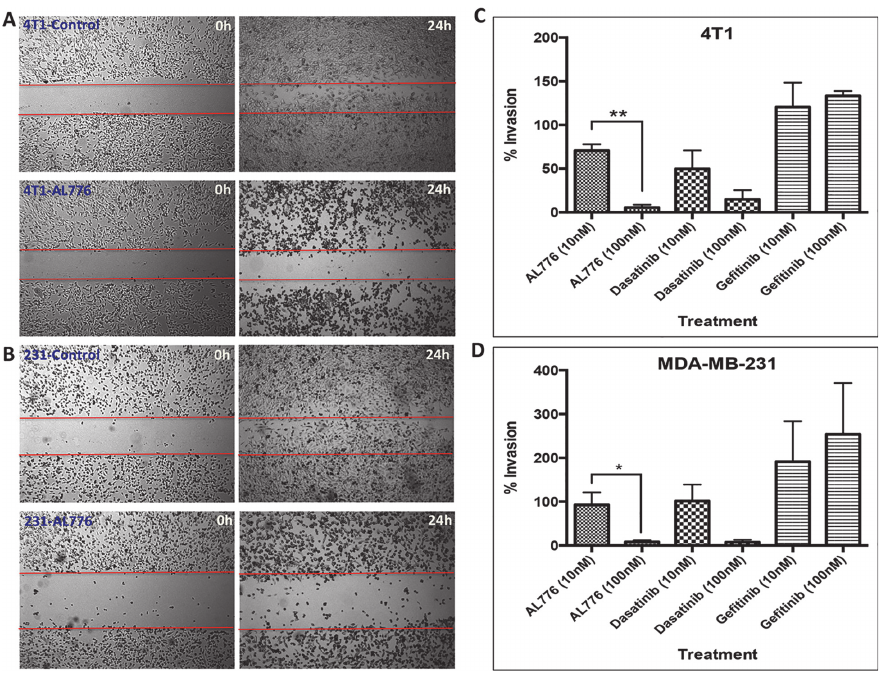
Fig 8. Anti-motility and anti-invasive properties of AL776 in 4T1 mouse mammary tumour and MDA- MB-231 triple negative breast cancer cell lines. ( A ) 4T1 and ( B ) MDA-MB-231 cells were treated with 100 nM of AL776 or control drugs gefitinib or dasatinib for a period of 24h and the wound-closure (scratch) was monitored at both 0h and 24h time points. ( C ) 4T1 or ( D ) MDA-MB-231 cells were treated with varying doses of AL776 (in comparison with dasatinib or gefitinib) for a period of 24h in a Boyden Chamber invasion assay. Cells were plated in serum-free media (top chamber) and allowed to invade across the layer of matrigel towards media containing 10% FBS (bottom chamber) through chemotaxis. Drugs were added to both the top and bottom chambers to maintain a uniform distribution. Cells were fixed, stained and quantified to generate the percentage of invading cells across the matrigel in comparison with untreated control cells. The histograms represent the average ± SEM of three independent experiments. Statistical analysis was performed using the unpaired two-tailed t-test and p values were obtained (p < 0.05 is significant): 4T1 ** (p = 0.001), MDA-MB-231 * (p <